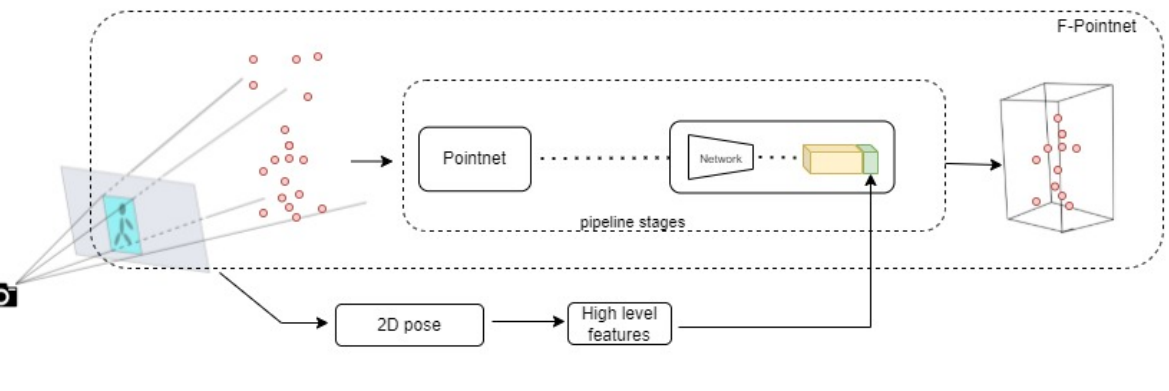
Figure 1. The whole proposed pedestrian pose based fusion approach incorporating the 2D pose features into the